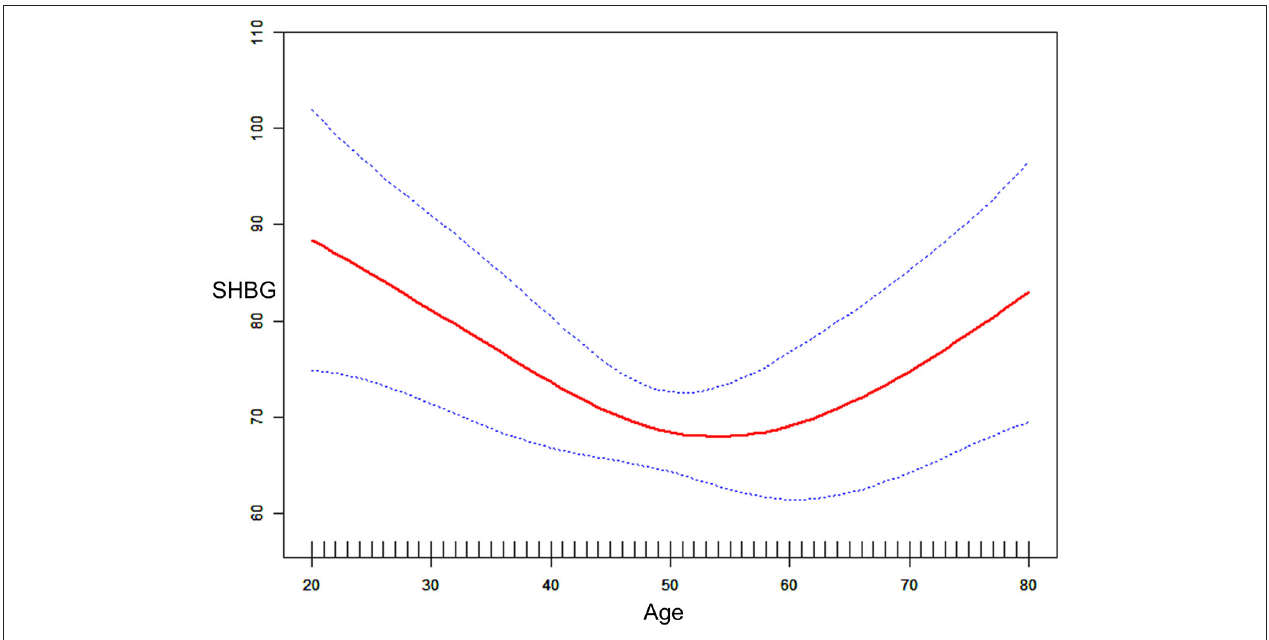
FIGURE 3 | Graphics of smooth curve fittings among age and SHBG.